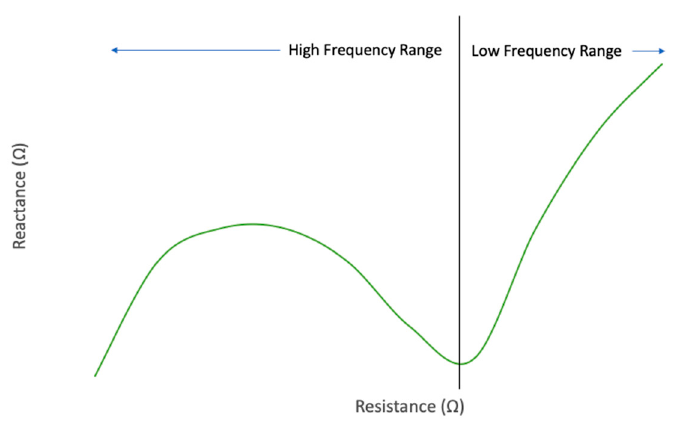
Figure 4. Impedance of concrete.